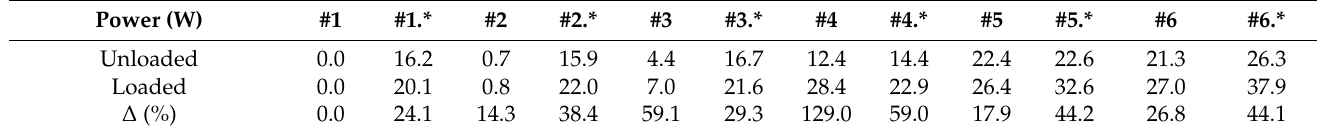
Table 5. Actuation power for different configurations.